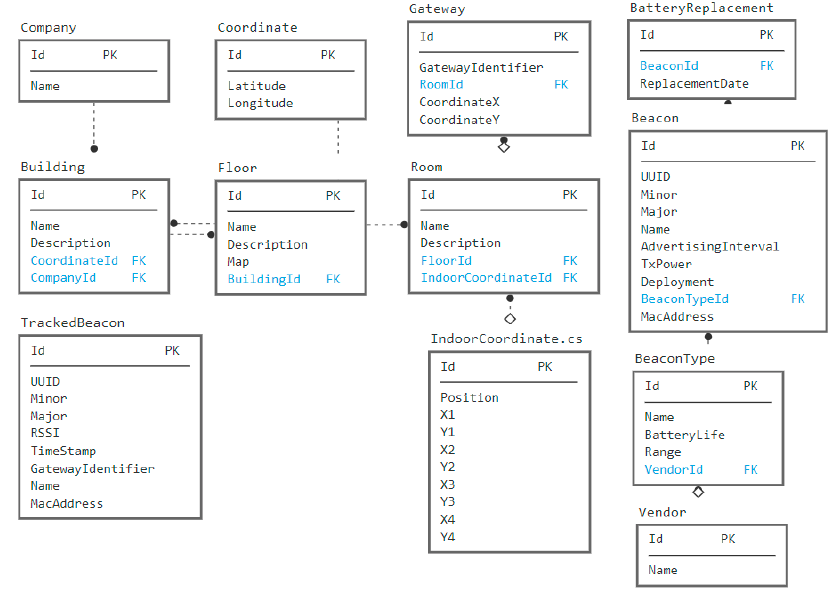
Figure 3. Database